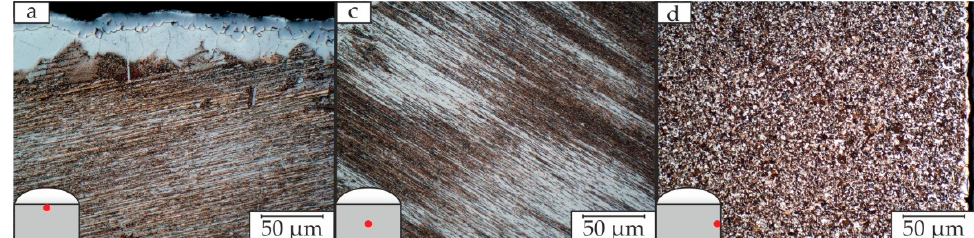
Figure 10. Microstructure in defined positions a, c and d according to Figure 1 (right) of a GE48 sample sintered at 1300 °C, with 10 min dwell time and 65 MPa pressure.